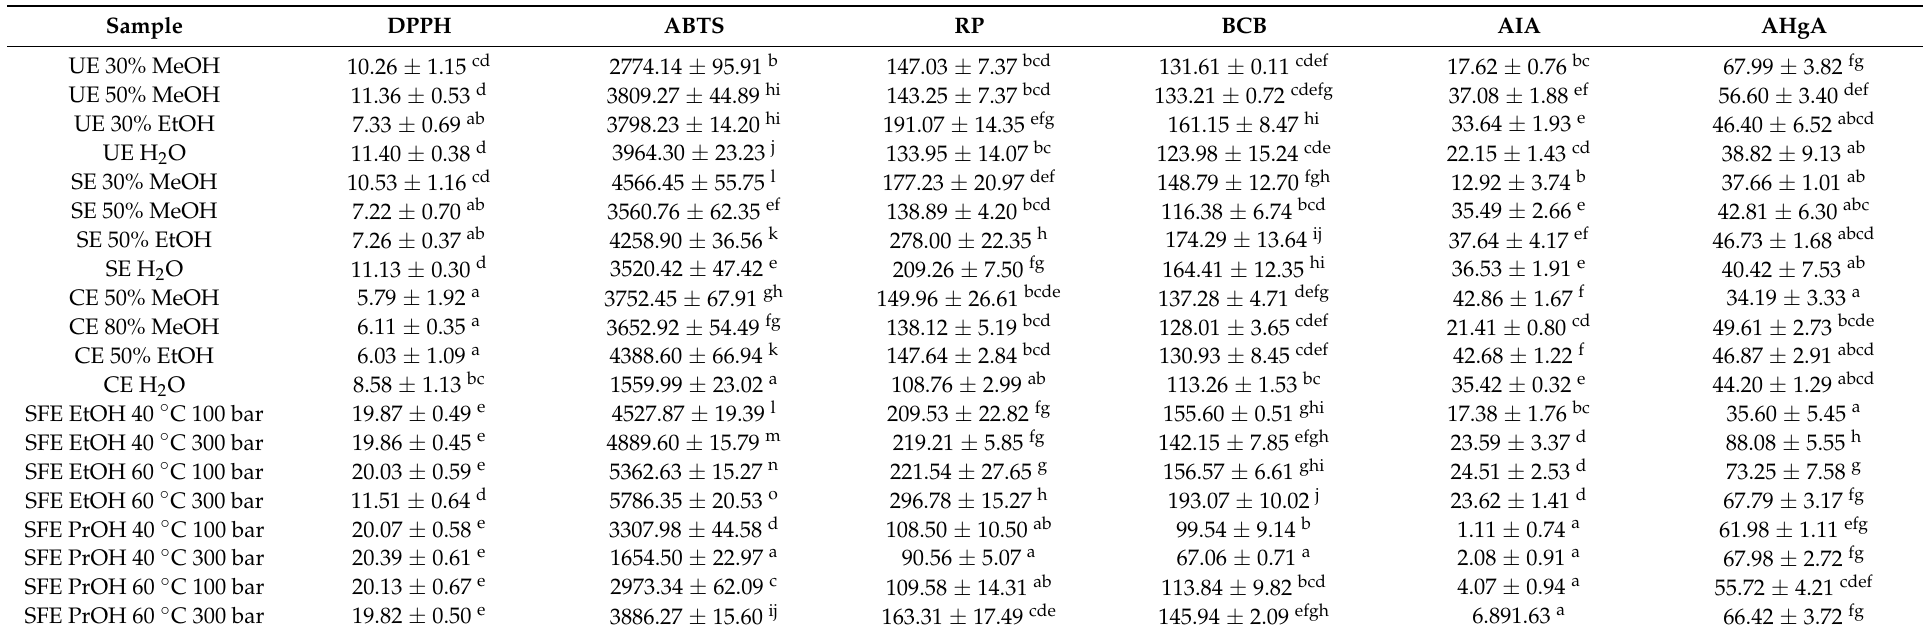
Table 3. Antioxidant and pharmacological activities of beetroot